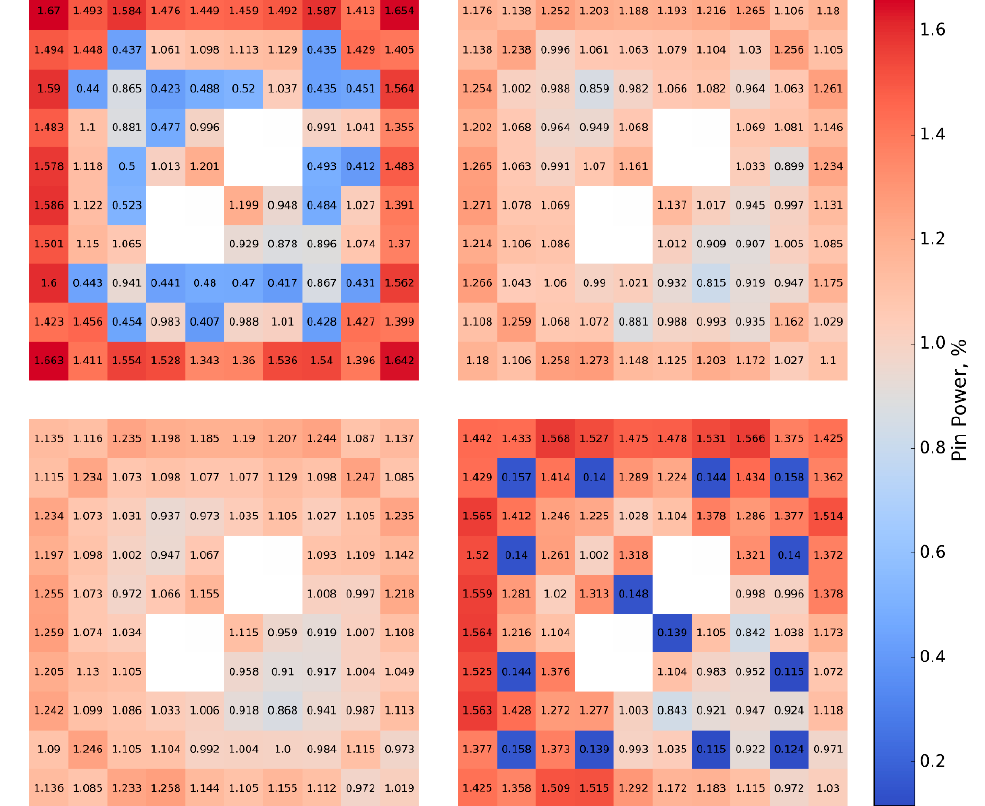
Figure 23. Pin power reconstruction from Serpent, where the pin power % is proportional to the total assembly power (100%). Top left , fresh fuel, Top right , 5 GWd/TU, Bottom left , 10 GWd/TU and Bottom Right , 30 GWd/TU.